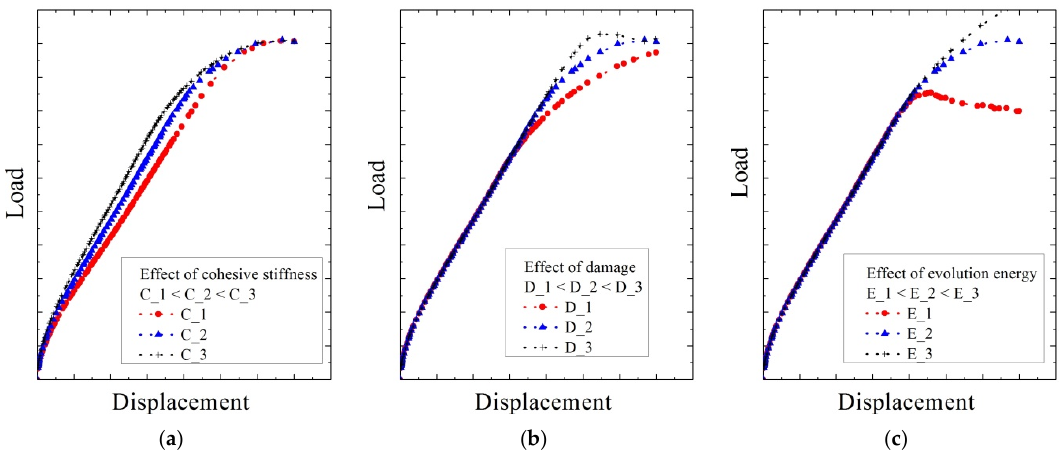
Figure 9. Numerical analysis results for linear block support tests obtained by varying the parameters of ( a ) cohesive stiffness, C, ( b ) maximum stress of damage initiation, D, and ( c ) evolution energy, E.